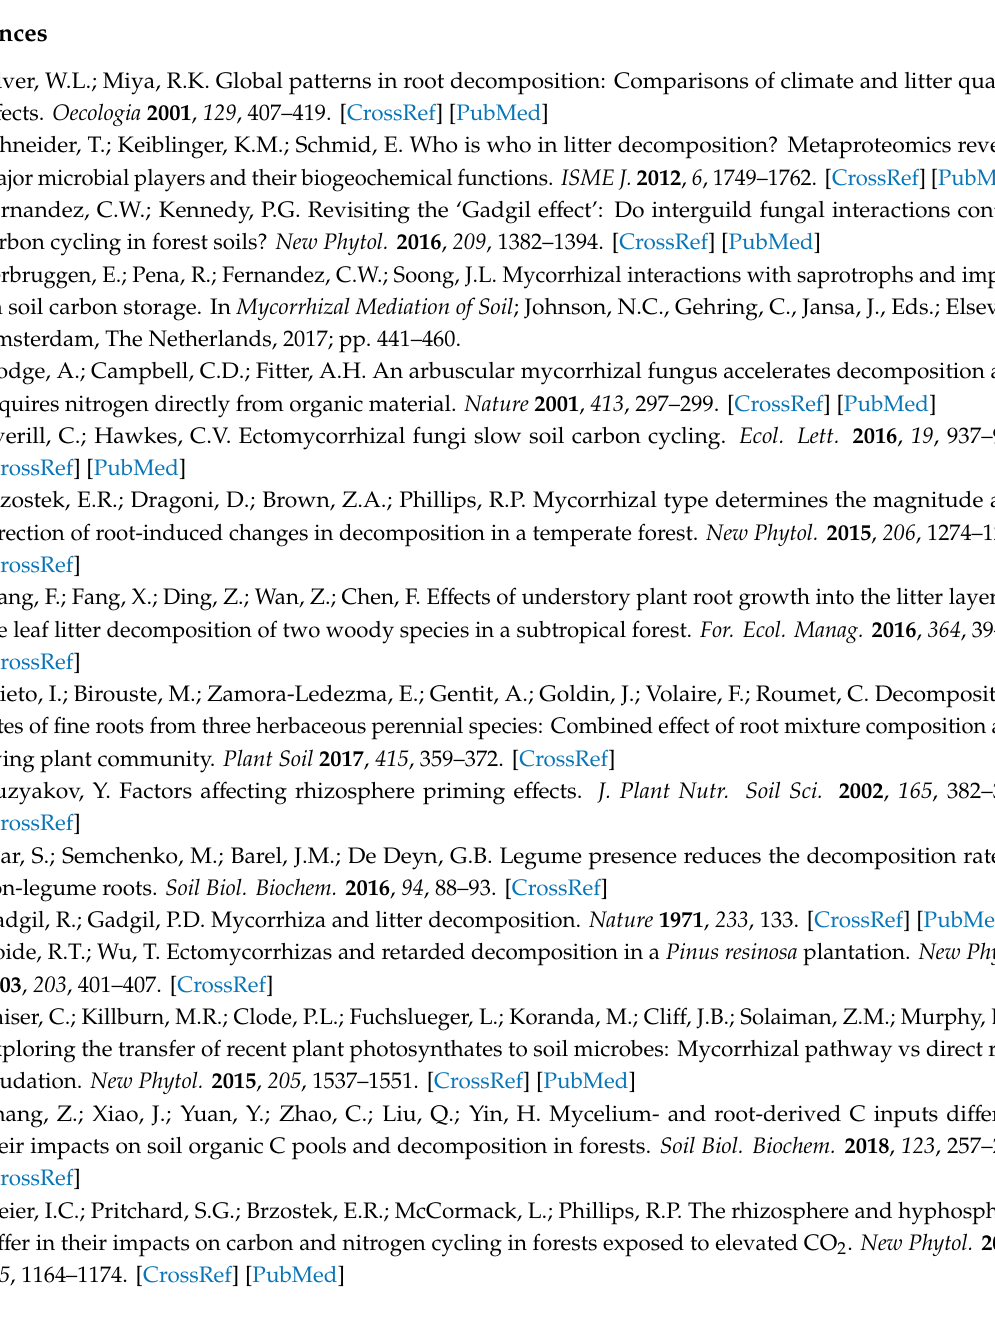
Figure S1: Di ff erences in root litter mass loss between 1-mm and 50- µ m mesh litterbags installed in unplanted pots, Figure S2: Di ff erences in activities of β -glucosidase (a) and phenol oxidase (b) between 1-mm and 50- µ m mesh litterbags installed in unplanted